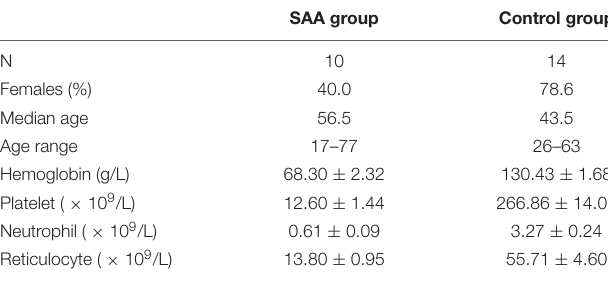
TABLE 1 | Clinical data for all the